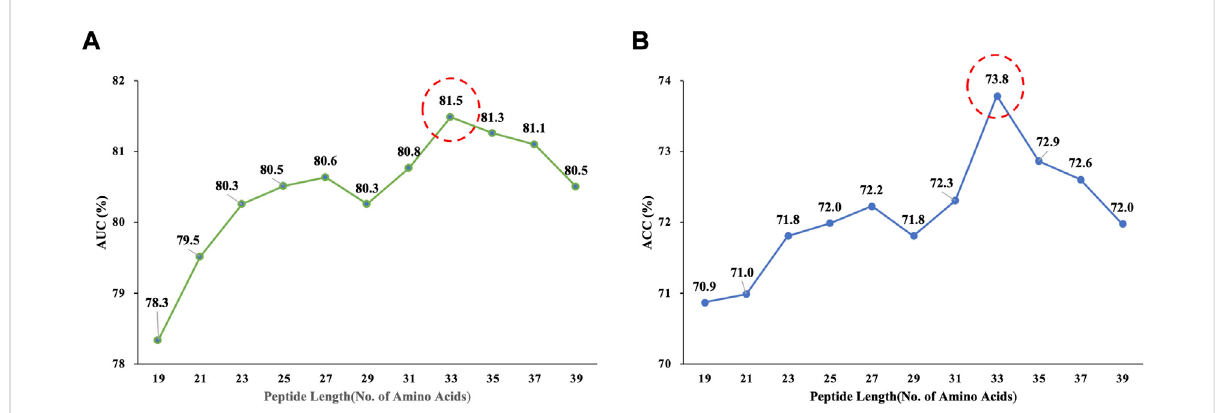
FIGURE 4 TheAccandAUCvaluescorrespondingtodifferentwindowsizesofDeep_KsuccSiteonthetrainingdataset. (A) AUCcorrespondingtowindow